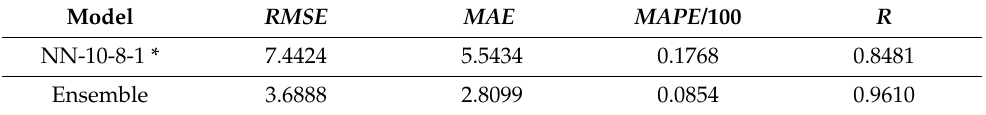
Table 4. Comparison of the optimal individual neural network and ensemble